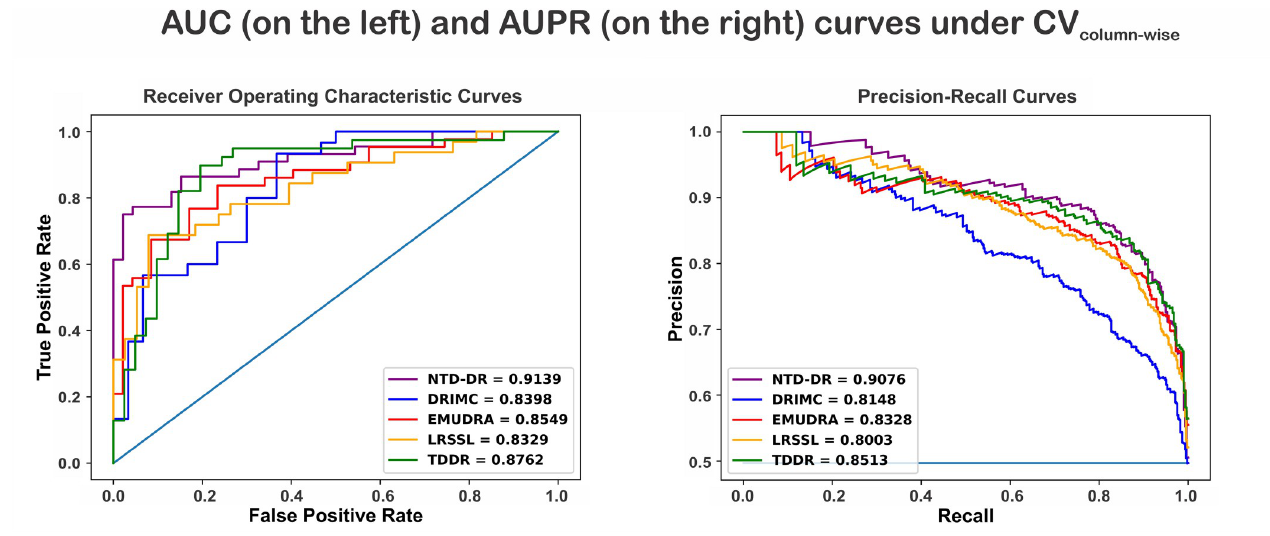
Fig 4. ROC and precision-recall curves of NTD-DR and the existing methods for Scenario CV column-wise using dataset P.